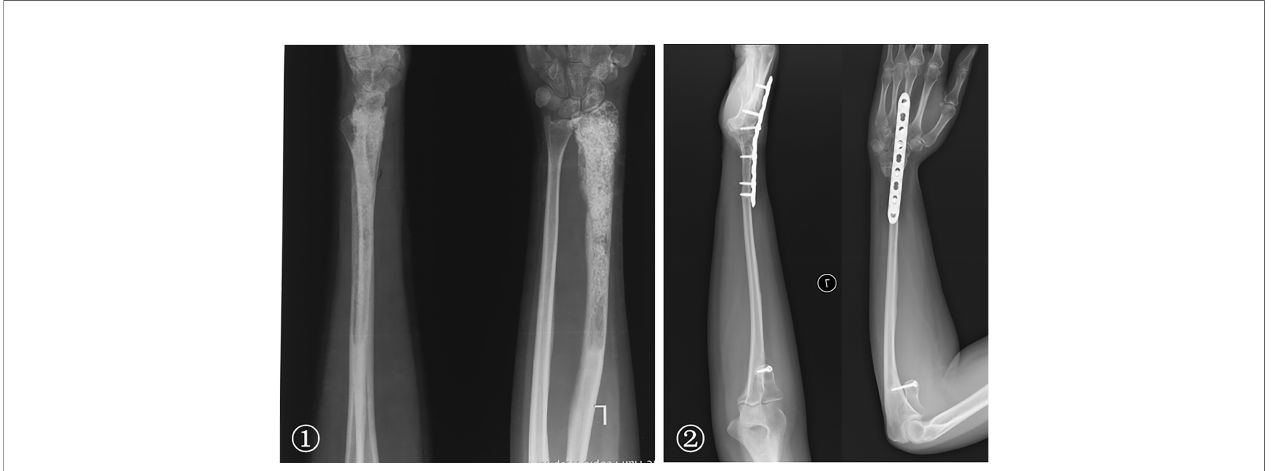
FIGURE 5 | ① A 29-year-old woman with low-grade central osteosarcoma of the middle and distal radius underwent unplanned excision and tumor recurrence. ② Radius resection and ulna centralization with wrist joint fusion was performed; satisfactory bone healing but a loss of forearm rotation is shown 65 months postoperatively.